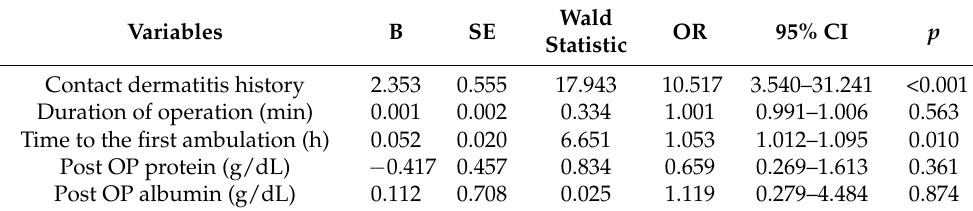
Table 3. Factors associated with the occurrence of MARSI. ( n =